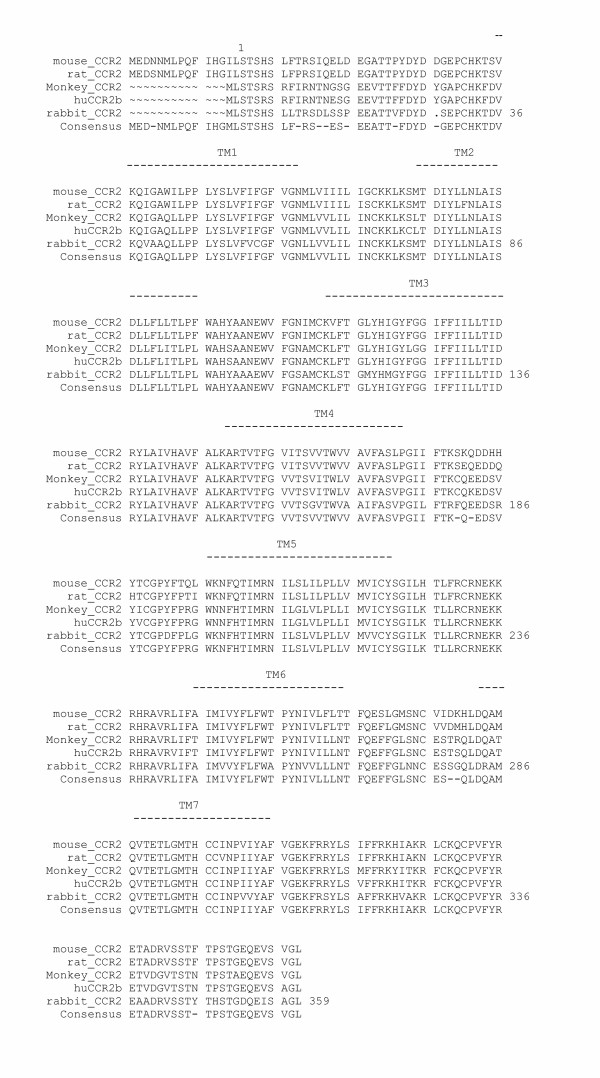
CCR2 peptide sequence alignment. The CCR2 peptide sequences from mouse, rat, monkey, human and rabbit are aligned and the consensus sequence is indicated in the bottom of the alignment. Transmembrane domains (TM) designated based on the human CCR2 sequence are also indicated.